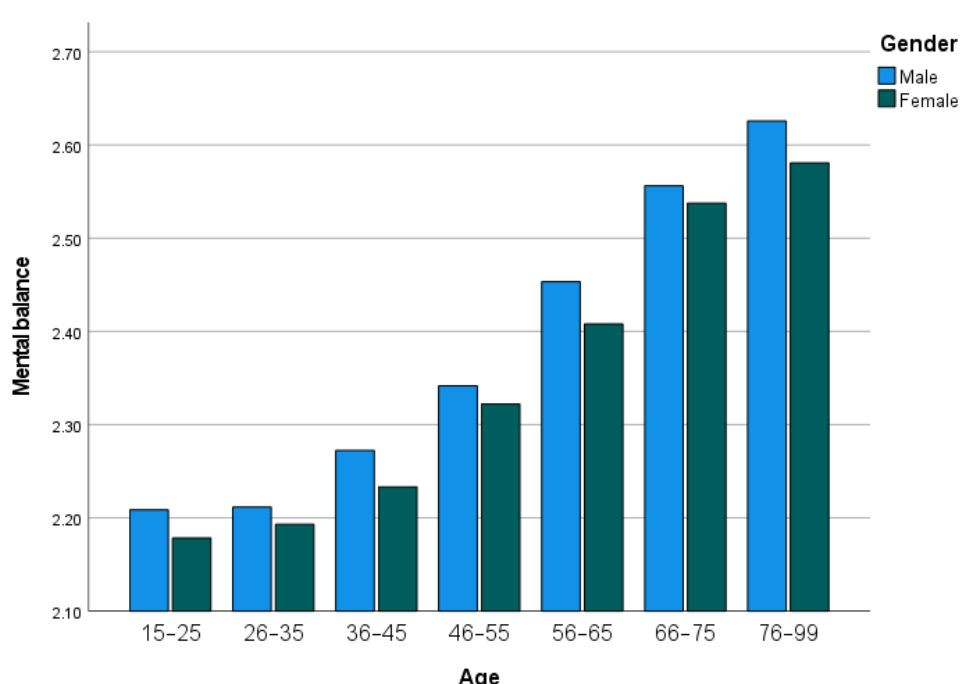
Figure 6. Mental balance across age and gender groups.